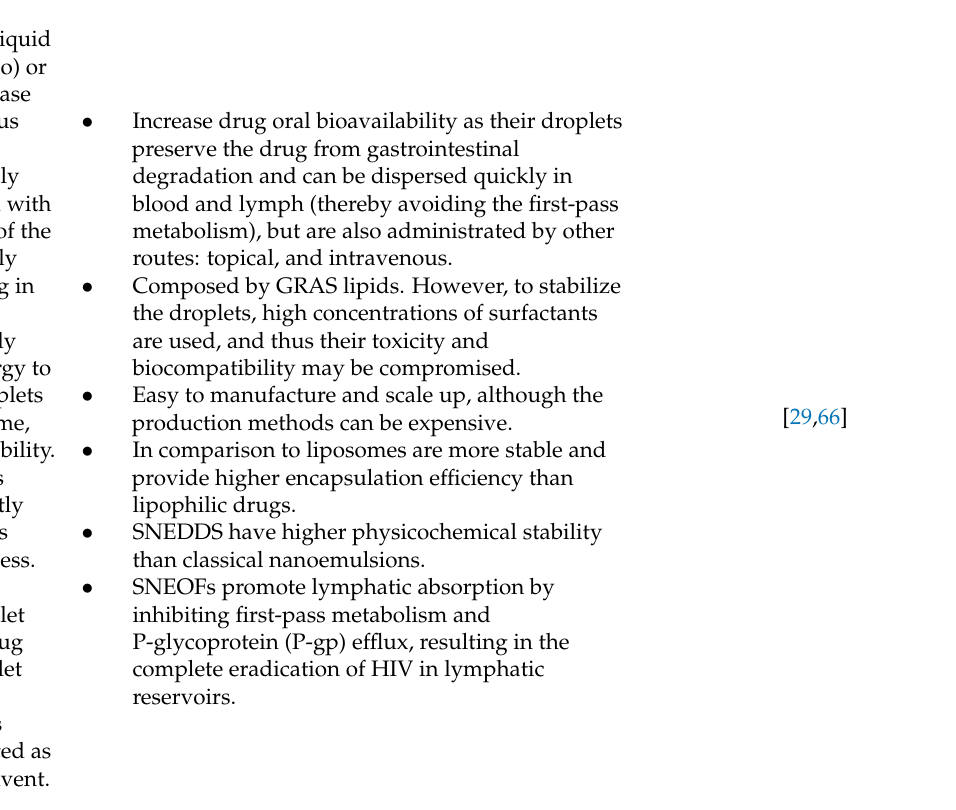
inhibiting first-pass metabolism and P-glycoprotein (P-gp) efflux, resulting in the complete eradication of HIV in lymphatic